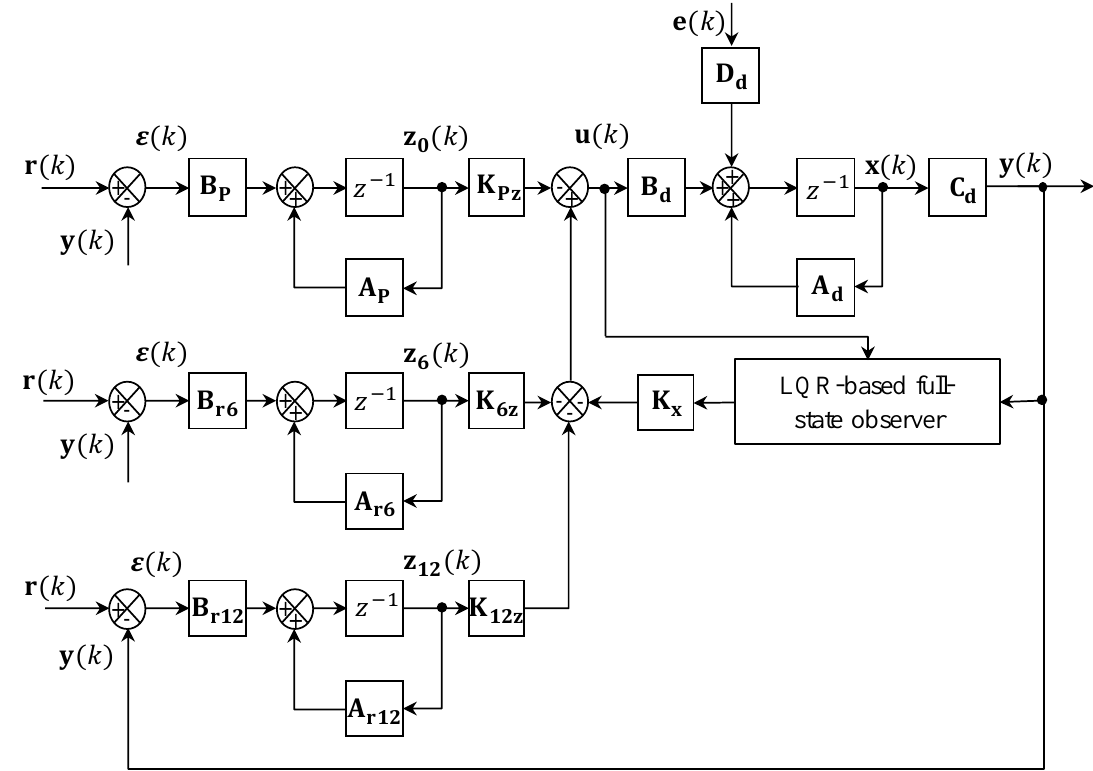
Figure 3. Detailed control block diagram of the proposed current controller.